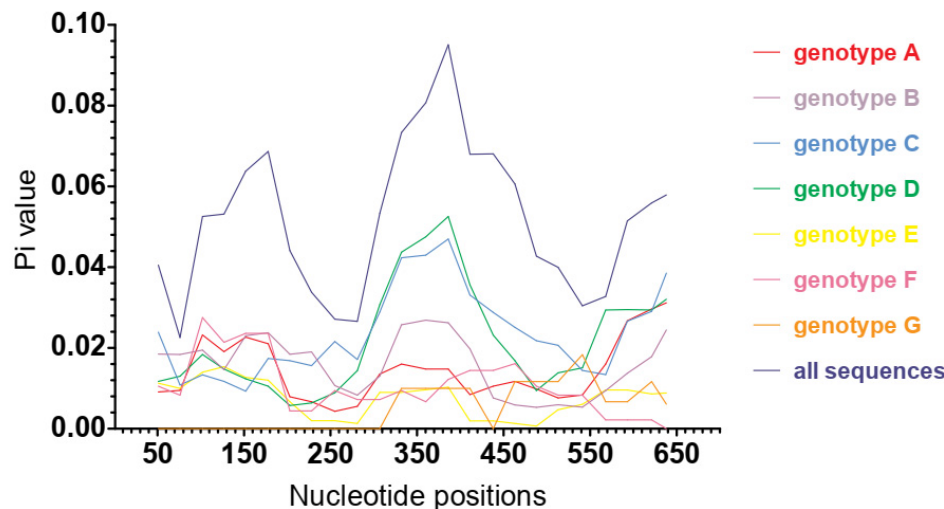
Figure 4. Genotypic variation of nucleotide diversity (Pi) estimated over mid-point nucleotide position in the HBV surface gene from blood donors (window length of 100 bp and step size of 25 bp). The MAFFT-aligned sequences of surface gene were 681 bp in length.